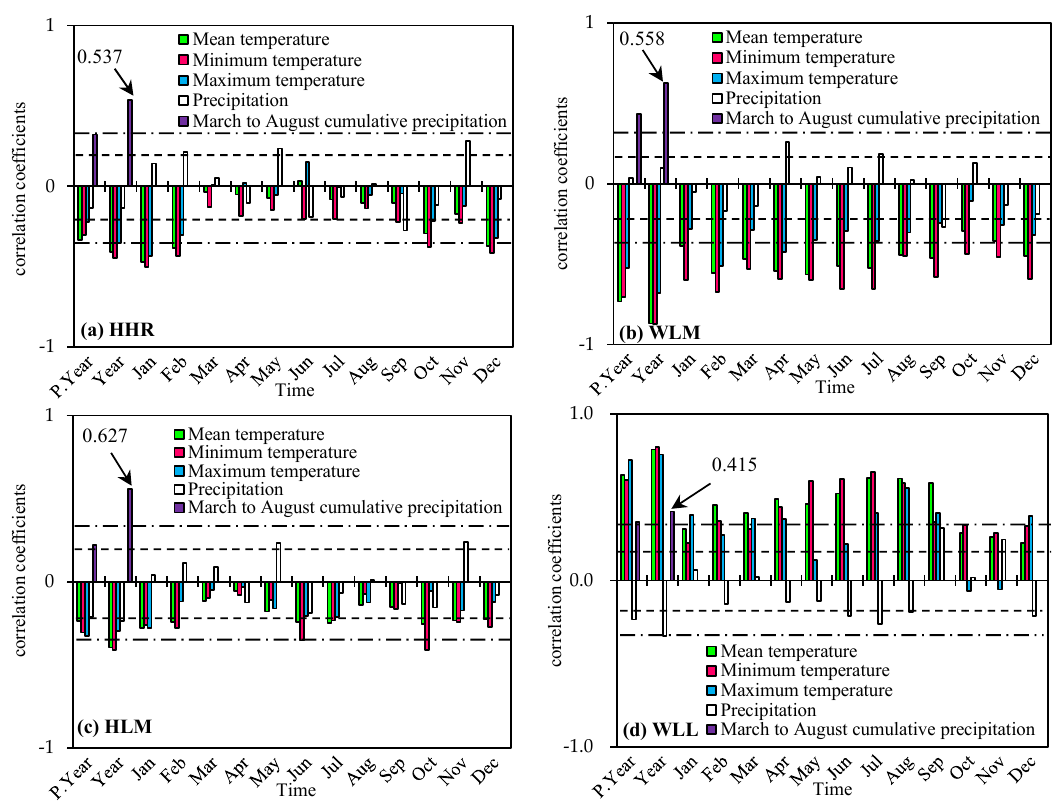
Figure 4. Correlation between annual and monthly climate factors and annual ring index in each region.